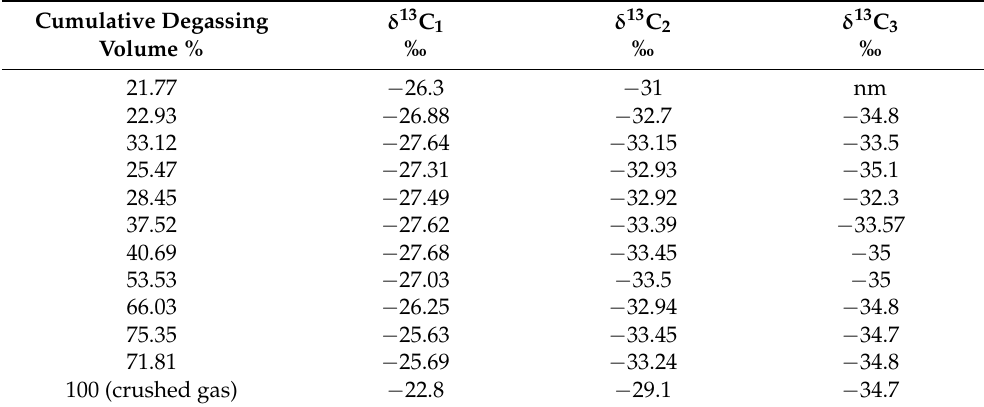
Table 3. Pressure core isotope ratio and cumulative degassing volume results. Nm—not measured. Cumulative